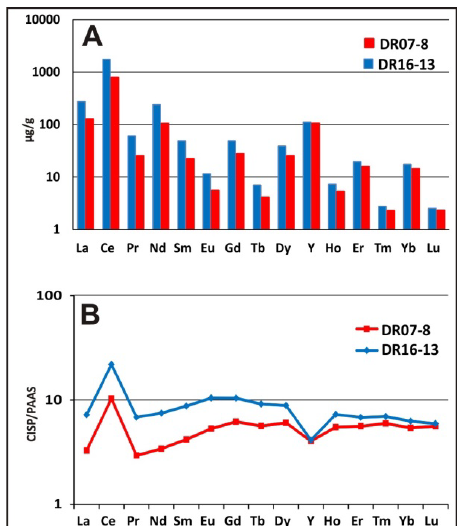
Figure 9. ( A ) Comparative graphic of the total concentration of REYs in both studied crusts; ( B ) PAAS normalised REYs plots for studied Fe–Mn crusts. PAAS from [68].